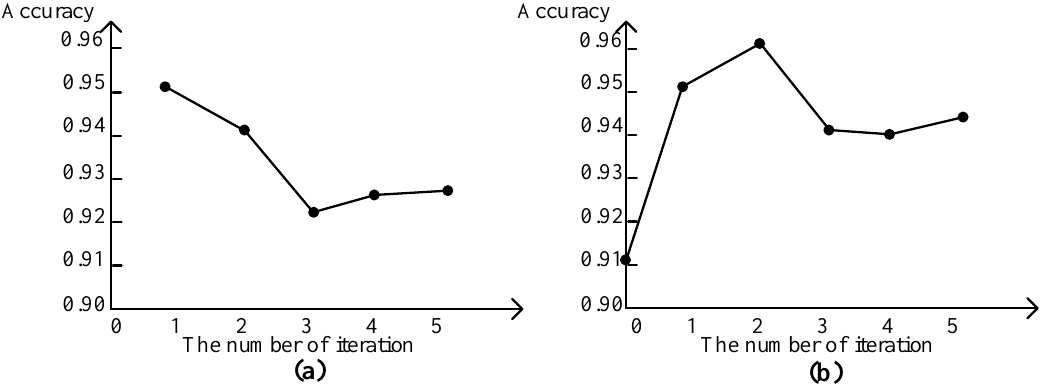
Figure 13. ( a ) Accuracy of label propagation during the iteration. ( b ) Accuracy of classification during the